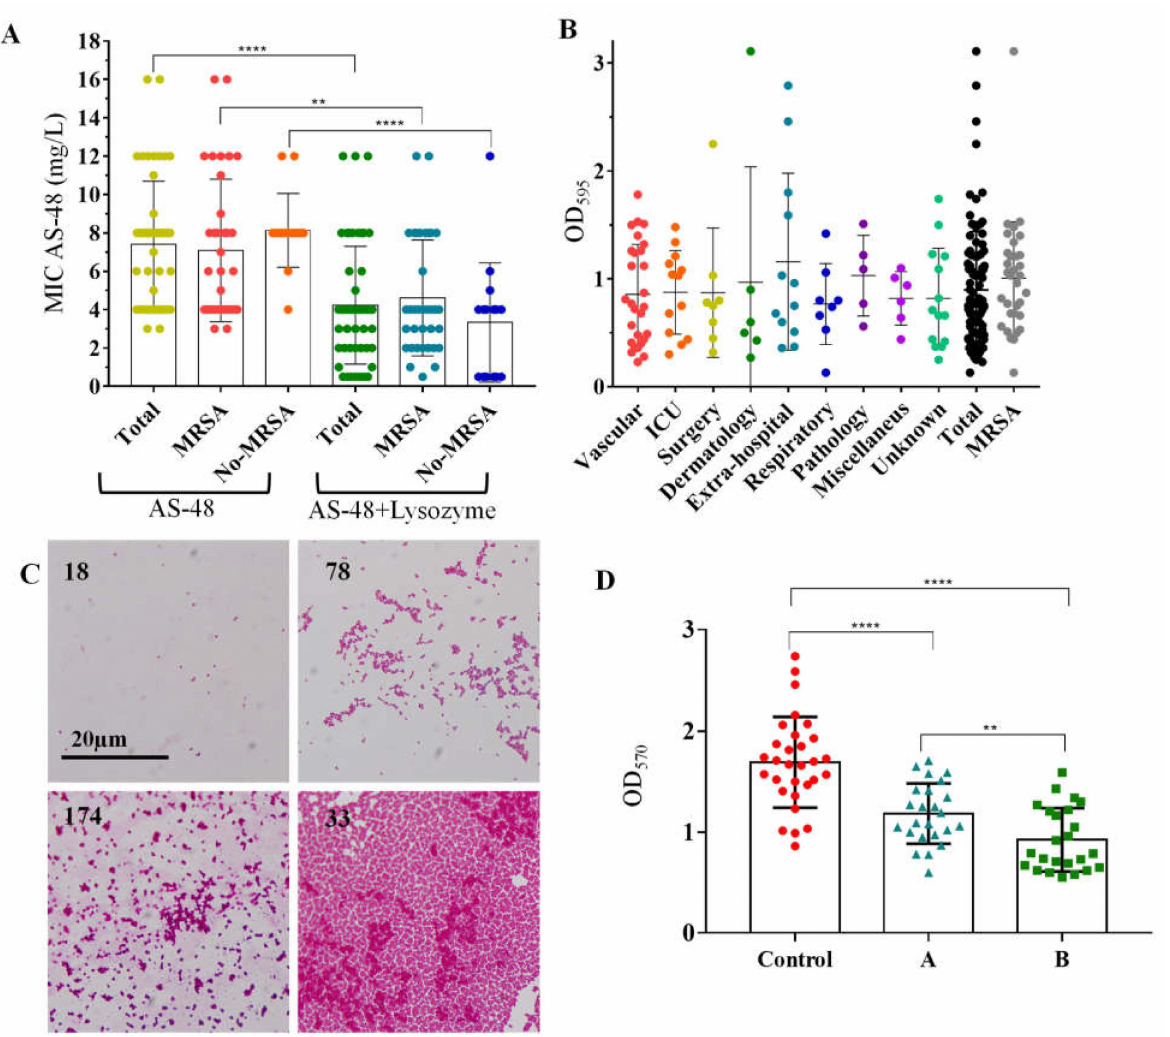
Figure 2. (A ) Antimicrobial activity of AS-48 alone or in combination with lysozyme against the clinical S. aureus isolates. Each dot represents one strain. **** Significant differences at p < 0.0001. ** Significant differences at p = 0.0032 ( B ) Evaluation of biofilm formation for the different isolates according to their isolation source. Each dot represents one strain. Total indicates these values for all strains and MRS for the OXA positive isolates ( C ) Optical microscopy of stained biofilms formed by strains representative of the different biofilm formation capacities (OD 595 ). Strain 18 OD 595 = 0.13, strain 78 OD 595 = 0.87, strain 174 OD 595 = 1.51, and strain 33 OD 595 = 3.11. ( D ) Antimicrobial activity of AS-48 on S. aureus 33 biofilms. A shows cell viability after 48 h in the presence of 32 mg/L AS-48 when kept unrenewed and B shows the cell viability of biofilms when washed after 24 h of treatment and added AS-48 again at the same concentration. The dots, triangles, and squares represent replicates for each of the indicated treatments or control. **** Significant differences at p < 0.0001. ** Significant differences at p =